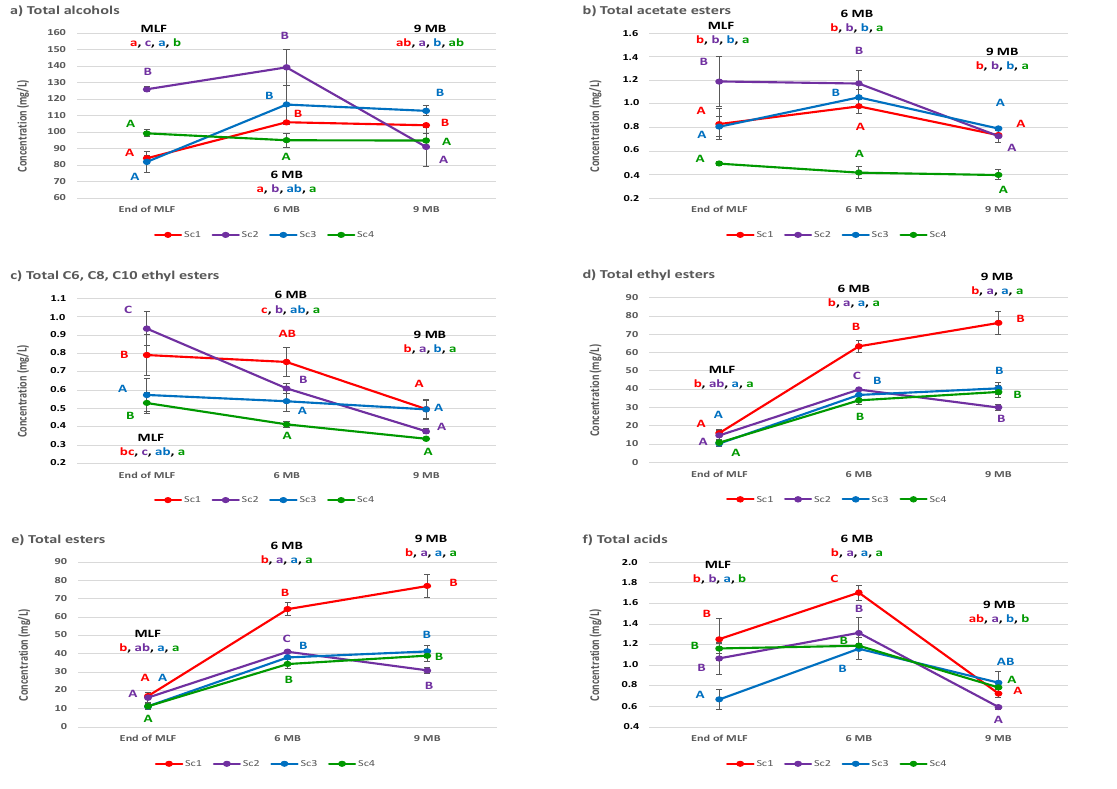
Figure 3. Volatile compounds concentration (mg/L) of the wines at the end of malolactic fermentation (MLF) and after 6 and 9 months of aging in bottles, 6 MB and 9 MB, respectively. All parameters are given as average values ± SD (n = 2). For each yeast, different capital letters indicate significant differences (Duncan test at p ≤ 0.05) between aging moments. For each moment, different lowercase letters indicate significant differences (Duncan test at p ≤ 0.05) between wines elaborated with the 4 yeasts.